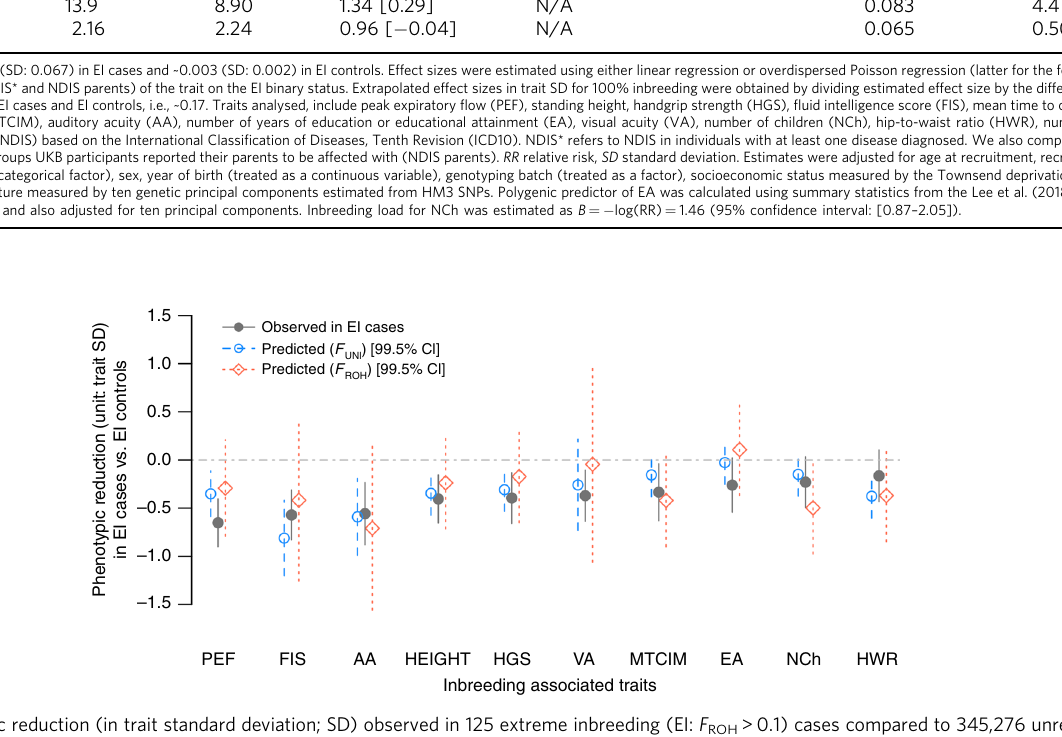
Standard error (s.e.)